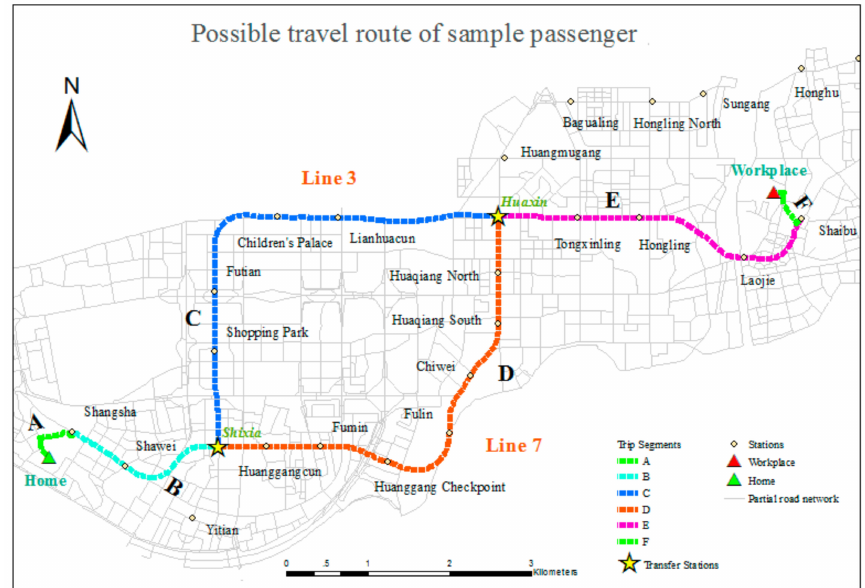
Figure 9. Possible travel routes of a sample